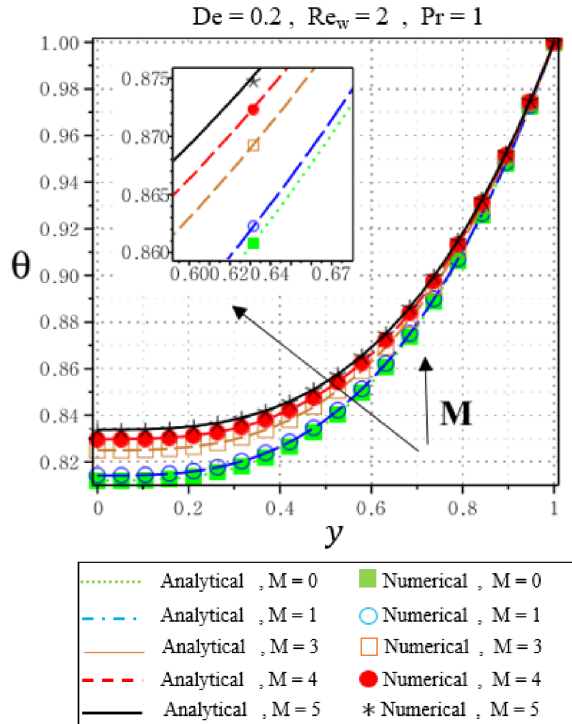
Figure 8. Dimensionless temperature predicted by analytical and numerical method (NUM) for different De Deborah number at M = 1, Re w = 3, Pr = 1, (cid:125) = − 1 . 5.